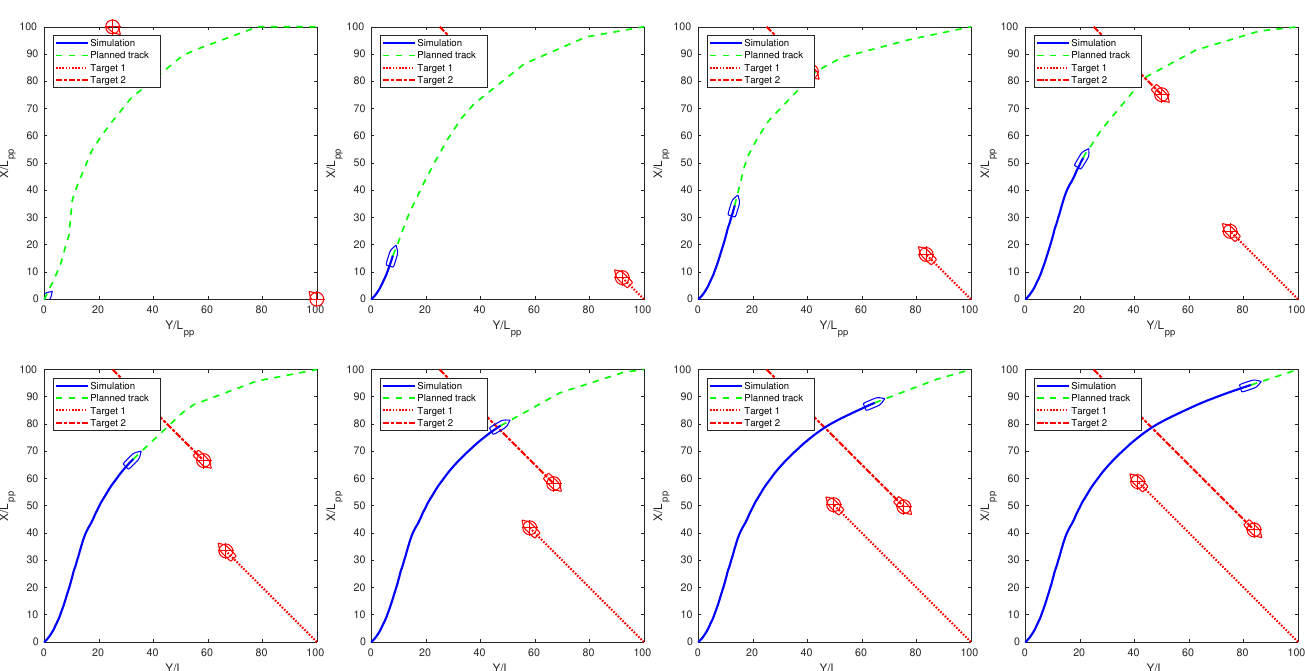
Figure 8. Scenario 1: simulation of a COLREG-non-compliant